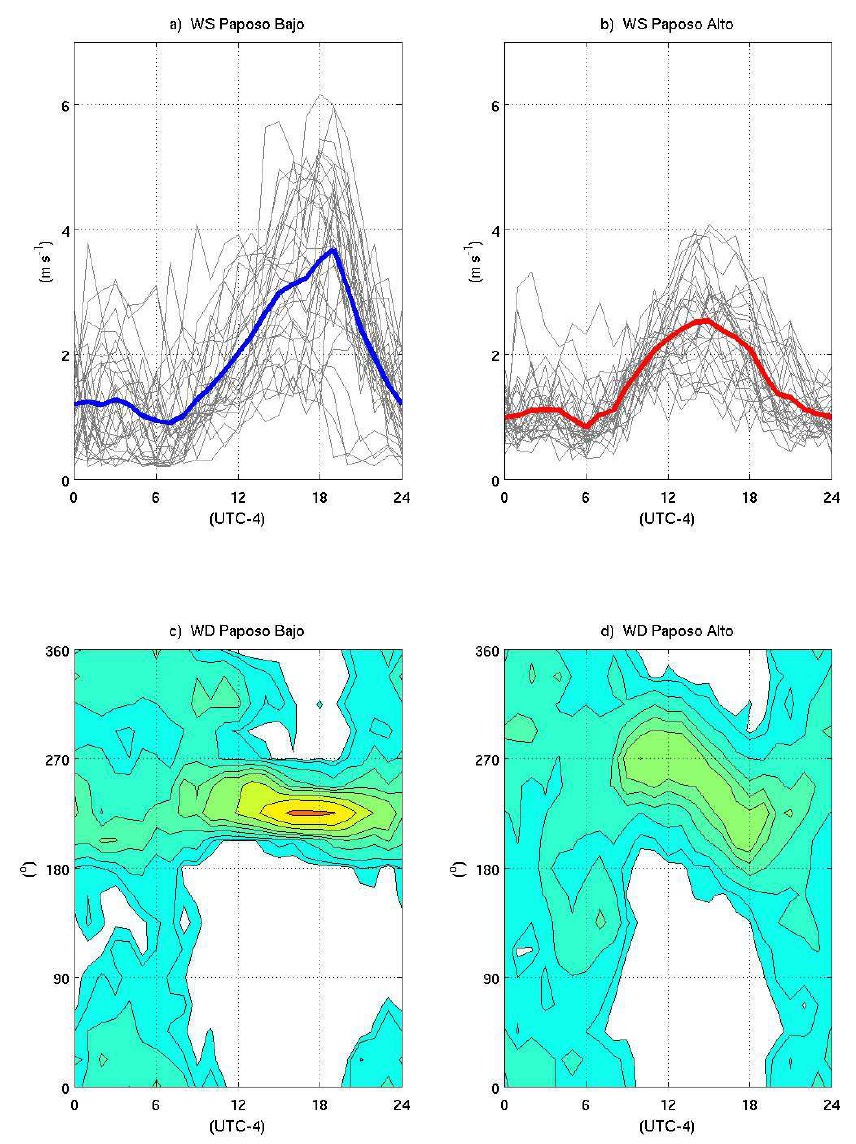
Fig. 4. (a) Diurnal cycle of wind speed at PB. Thin gray lines show daily series, the mean diurnal cycle in bold; (b) as (a) but for PA; (c) frequency of occurrence of wind directions throughout the day for PB, warmer colors depict higher frequencies; (d) as (c) but for PA. Figure 4. a) diurnal cycle of wind speed at PB. Thin gray lines show daily series, the mean 2 1000 m (especially in the afternoon soundings), diurnal cycle in bold; b) as a) but for PA; c) frequency of occurrence of wind directions 3 throughout the day for PB, warmer colors depict higher frequencies; d) as c) but for PA. 4